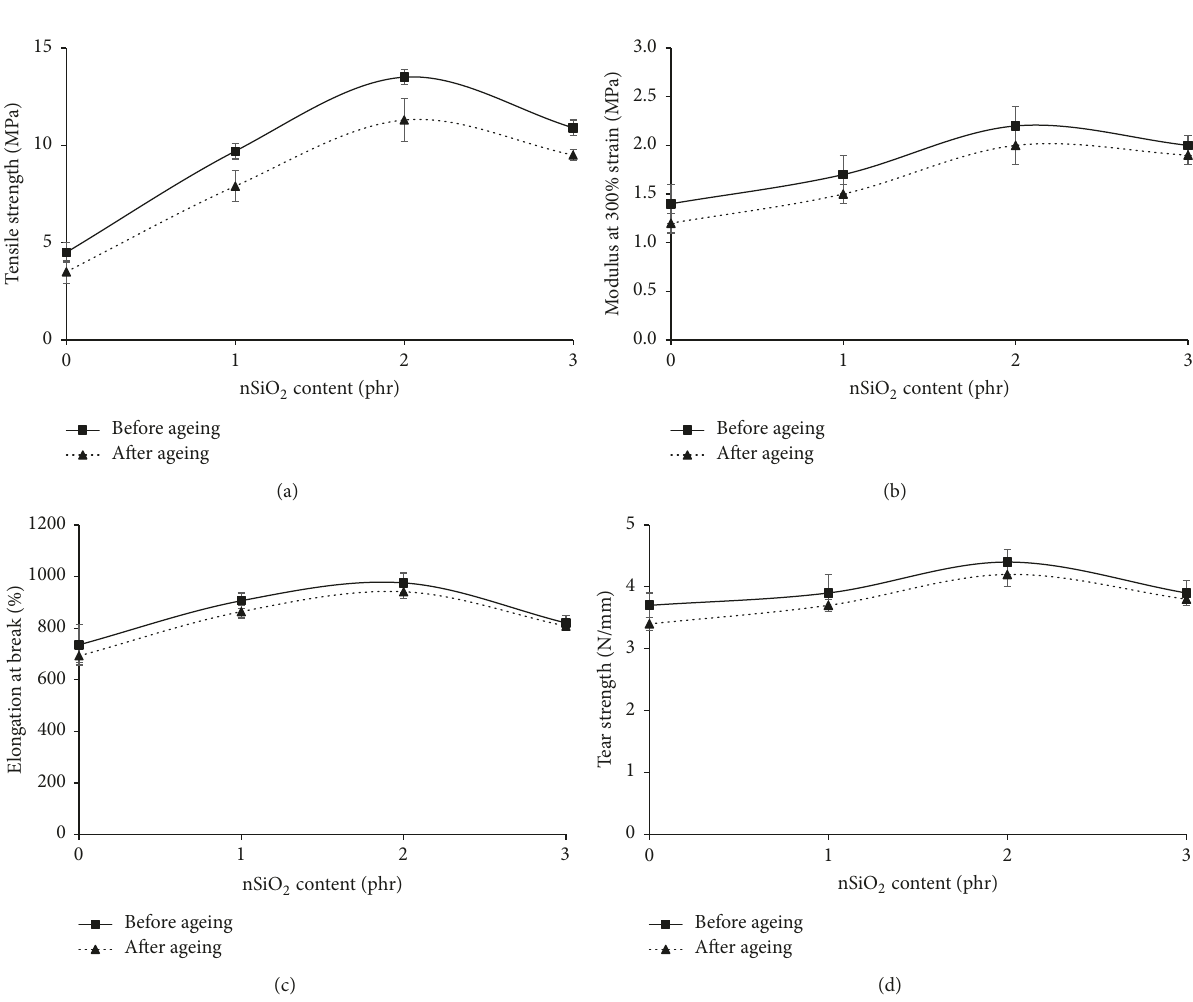
Figure 5: Mechanical properties of ENR 40/nSiO 2 nanocomposites in terms of (a) tensile strength, (b) M300, (c) elongation at break, and (d) tear